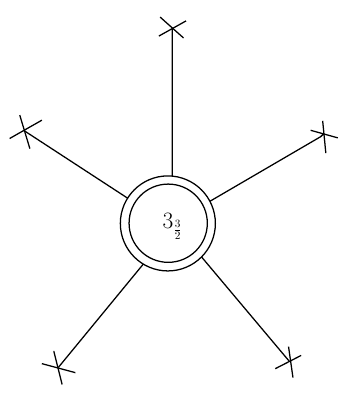
Figure 5 . The theory of (cid:12)ve copies of T x with SU(3) = Z 3 gauged at level k = 3 = 2, dual to a WZ model of (cid:12)ve chiral (cid:12)elds.